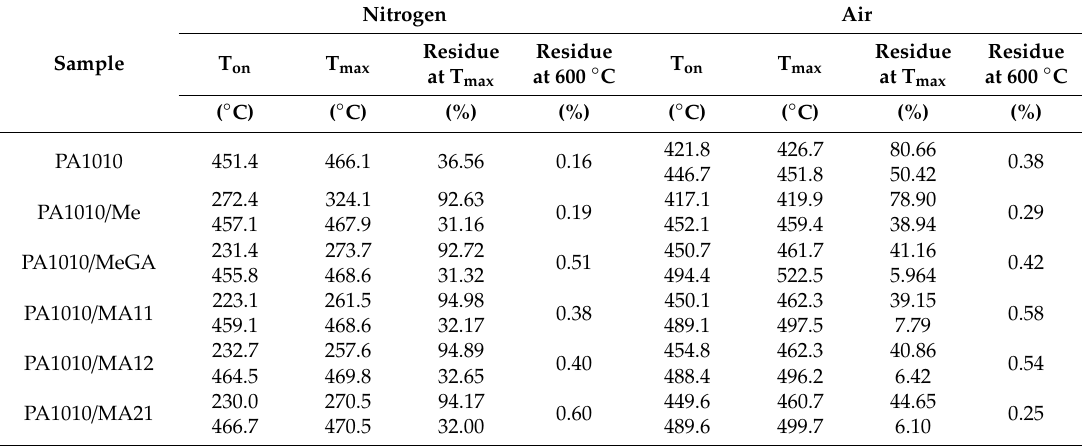
Figure 5. Thermogravimetric curves (TG) and their derivatives (DTG) for PA1010 composites in nitrogen ( a , b ) and in air ( c , d ). Table 4. TG/DTG data corresponding to PA1010/Me/MeGA/MA composites in nitrogen and air